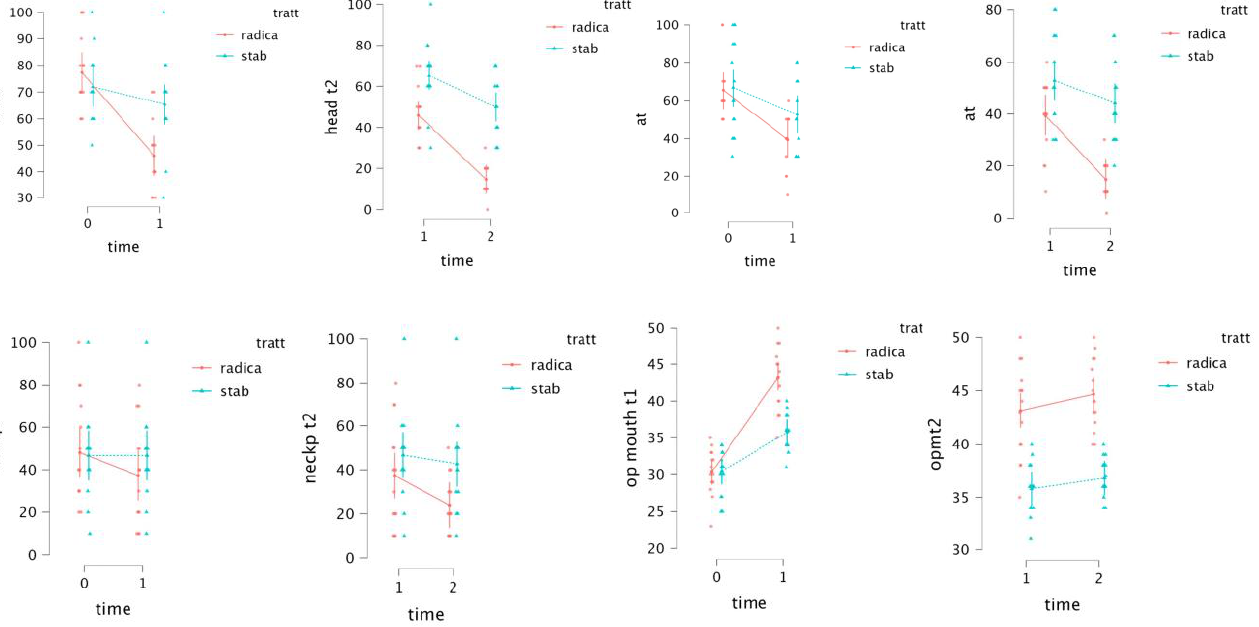
Figure 4. Plots from the GLMM. In patients using the stabilization splint, there were no statistically significant differ- ences between T0 and T2 for neck pain VNS scores, determined by comparing the values in Tables 1 and 2 (T0 = 53 ± 20.02 and T2 = 42.667